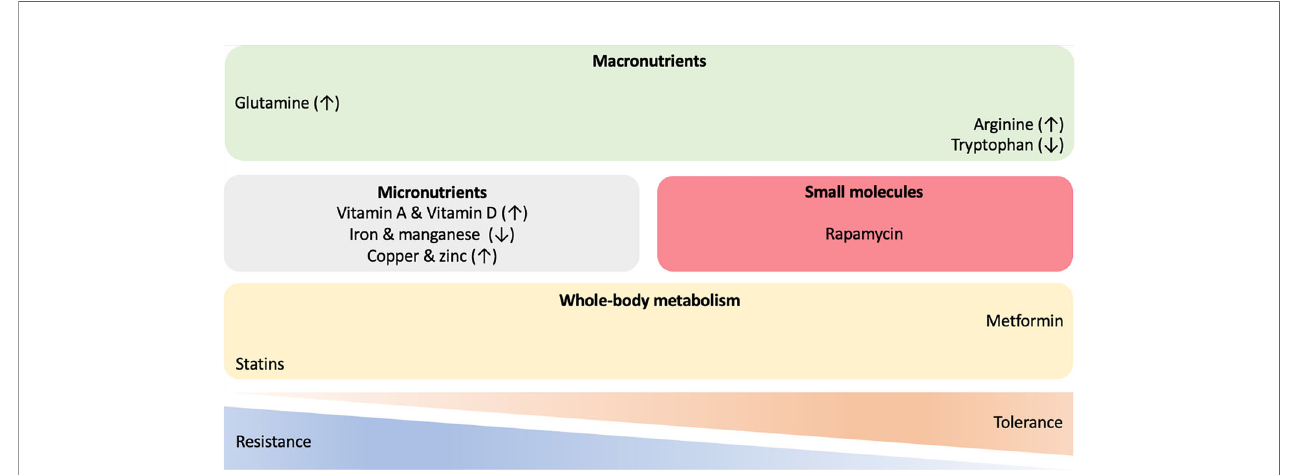
FIGURE 3 | Host-directed therapies in mycobacterial infections. A wide range of approaches and molecules are being investigated to identify novel immune- metabolic targets for treatment of mycobacterial diseases. Therapeutic interventions with macronutrients, micronutrients and small chemical molecules, as well as compounds targeting whole-body metabolism have the potential to shift the resistance/tolerance balance of the host when challenged with mycobacteria. ↑ increased; ↓